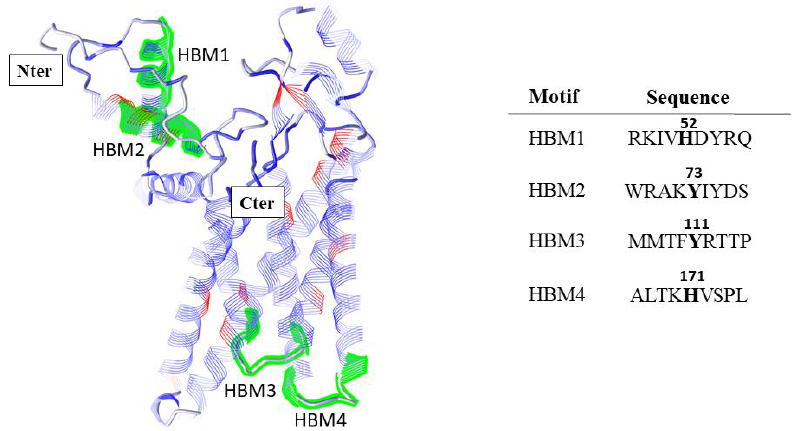
Figure A1. Predicted HBMs in human SFXN1. Left panel: The putative HBMs on SFXN1 predicted structure are highlighted (in green). Right panel : Sequences of the 9mer motifs in SFXN1 corresponding to predicted HBMs. The position of the potential heme-coordination site (Cys, His or Tyr) is shown (bold).